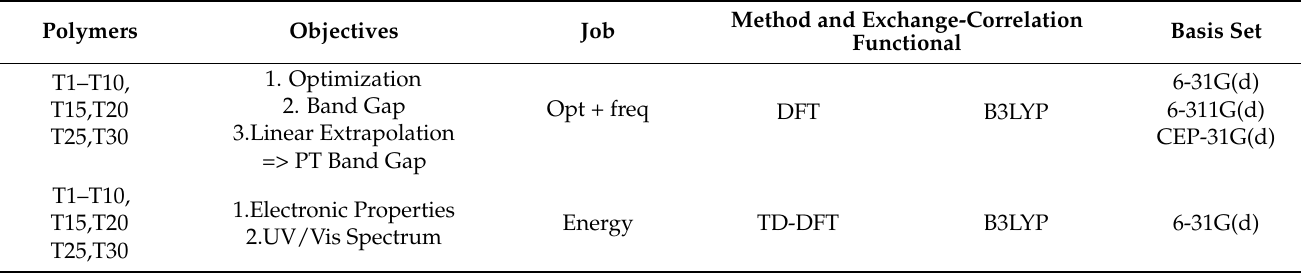
Table 1. Calculation method, exchange–correlation functional, and basis set used in Gaussian 09 for the calculation of the band gap, electronic properties, and UV/Vis spectra of the PT polymers T1–T10, T15, T20, T25, and T30. Polymers